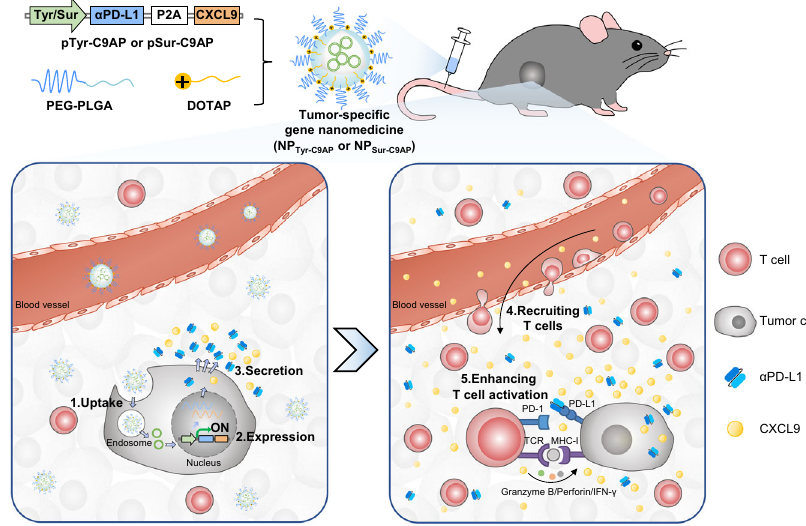
Fig.1|Schematicillustrationofdevisingtumor-speci fi cgenenanomedicinesto recruit and activate T cells for enhanced immunotherapy. The Tyr or Sur promoter-driven CXCL9 and α PD-L1 coexpression plasmid (pTyr-C9AP or pSur- C9AP)wasencapsulatedintoNPsfabricatedwithpoly(ethyleneglycol)-poly(lactic- co -glycolic acid) (PEG-PLGA) and cationic lipid 1,2-dioleoyl-3-trimethylammonium- propane (DOTAP) to prepare tumor-speci fi c gene nanomedicines (NP Tyr-C9AP or NP Sur-C9AP ).P2A(aself-cleaving 2Apeptide) wasincorporated into the α PD-L1-P2A- CXCL9 cassette for the separate translation of CXCL9 and α PD-L1. After i.v